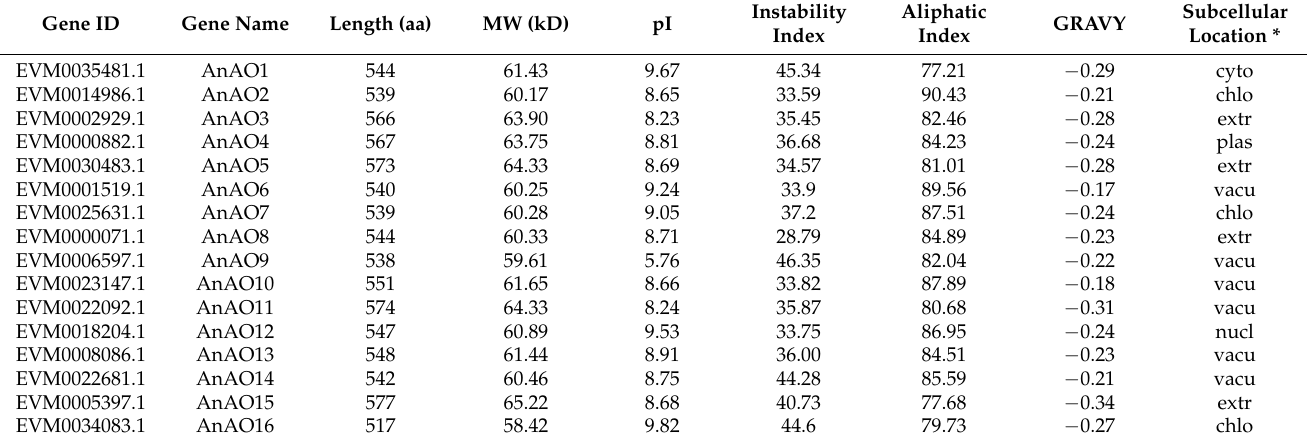
Table 1. Characterization of predicted AOs in A. nanus.